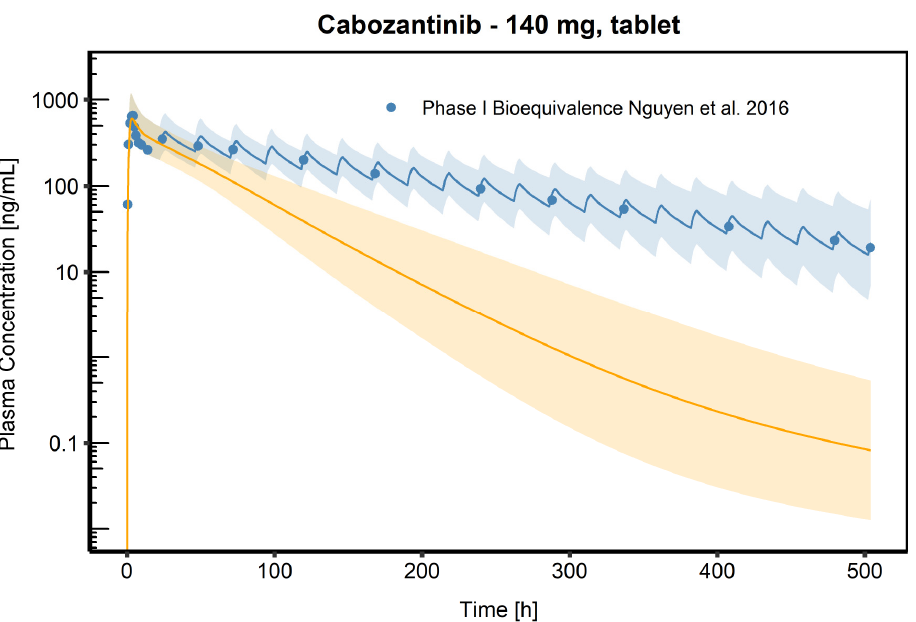
Figure 3. Comparison of simulated CAB venous blood plasma concentration time profiles (semi-logarithmic) following oral administration of 140 mg CAB (tablet formulation). The blue shaded area represents the geometric mean SD for population simulations with an implemented EHC process. The orange shaded area represents the geometric mean SD for population simulations without an implemented EHC process. Geometric means are shown as blue line (with EHC), respectively, as orange line (without EHC). Observed data are shown as blue dots.